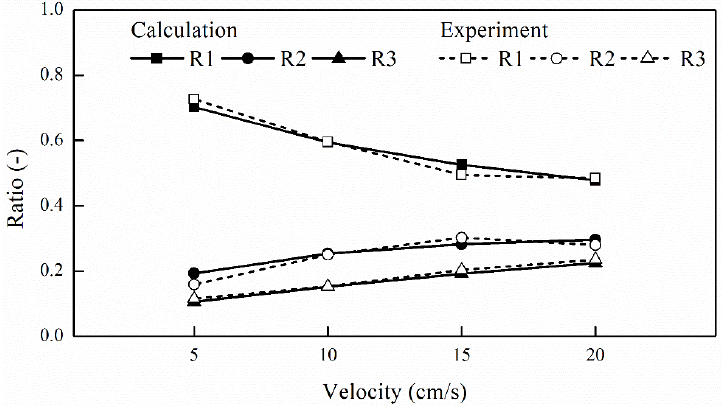
Figure 8. Ratios of tension force on the mooring lines from numerical simulation and physical model test.